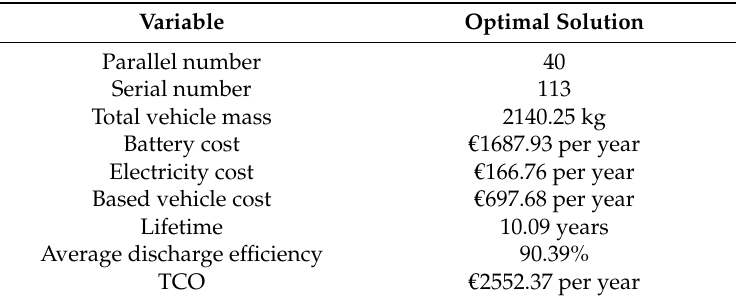
Figure 8. The GA method calculation process. Table 5. The optimal solutions by genetic algorithm.